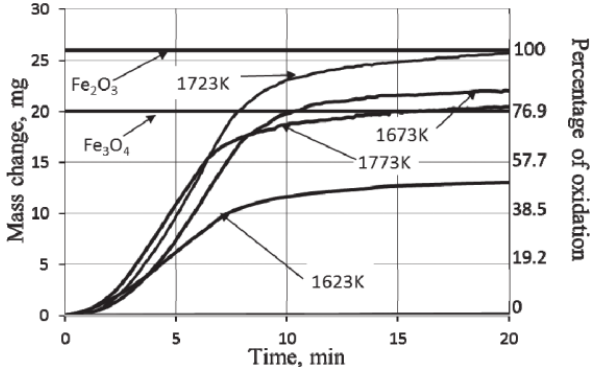
Fig. 2: The isothermal mass changes curves for the following composition: 25 mass% FeO – 37.5 mass% CaO – 37.5 mass% SiO for different temperatures.